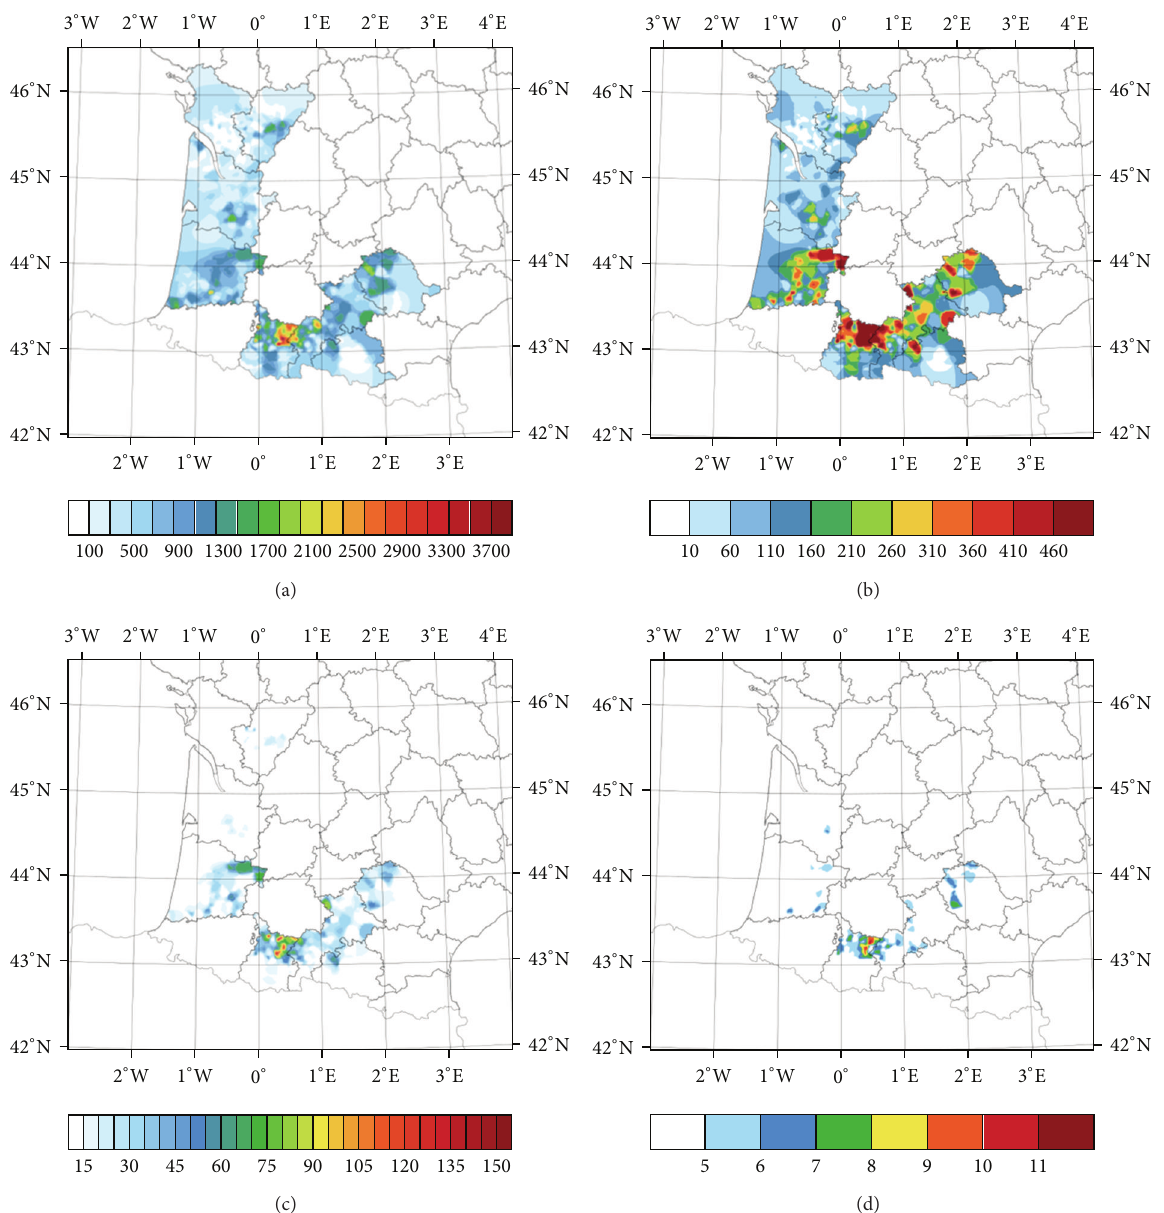
Figure 2: Spatial distribution of the average of variables: (a) number of impacts/m 2 , (b) ice mass (g/m 2 ), (c) kinetic energy (J/m 2 ), and (d) maximum diameter (mm) for the period of study between 1990 and 2010.